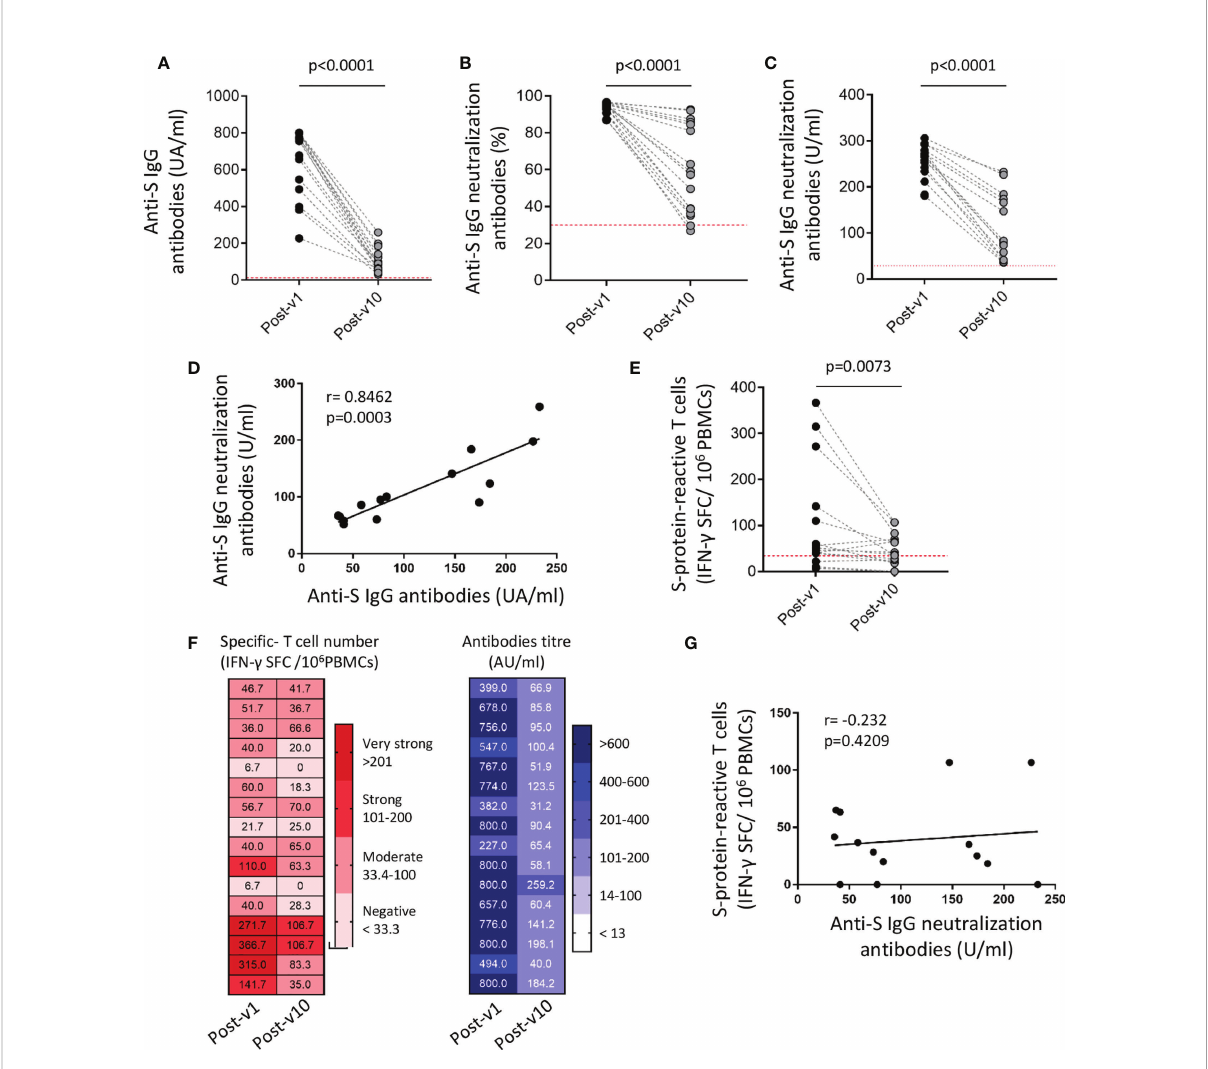
FIGURE 4 SARS-COV-2-speci fi c humoral and cellular immune responses decline over time but persist 10 months after vaccination. The titer of anti-S IgG and neutralizing antibodies (A – C) , the correlation between them (D) and the frequency of S protein-speci fi c T cells (E) were assayed in blood samples (n=16) obtained 1 month (Post-v1) and 10 months (Post-v10) after full vaccination. (F) Global distribution of the number of speci fi c T cells (left) and total S IgG titers (right) in samples (n=16) obtained at 10 months (Post-v10) after receiving the second dose of the vaccine, and comparison with the values obtained at 1 month (Post-v1) after vaccination. Numbers indicate the S-speci fi c T cells number and antibodies titers and each line represents one ICU worker. (G) Correlation between neutralizing antibodies and the number of spike-reactive T cells in ICU workers at 10 months after full vaccination. Statistical comparisons were performed by Wilcoxon test and correlation with Spearman correlation coef fi